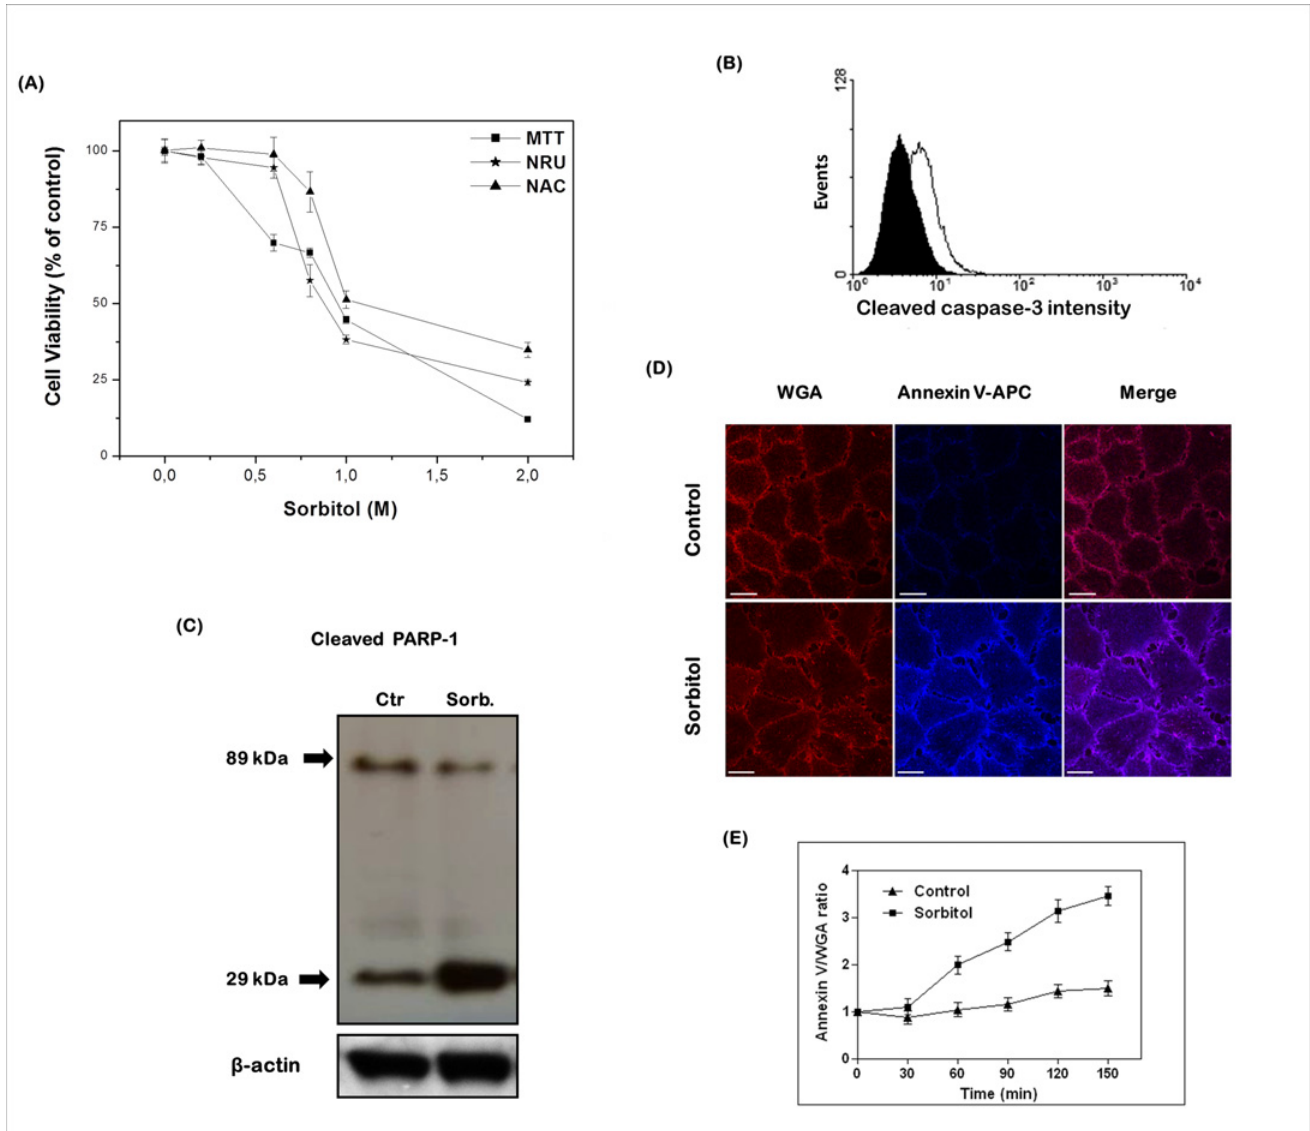
Fig 1. Sorbitol cytotoxicity in HaCaT cells involves induction of apoptosis. (A) Confluent layers of HaCaT cells were challenged with different concentrations of sorbitol (0.2 – 2 M in serum-free culture medium) for 2 h, and cellular viability was assessed by three different endpoints assays [MTT reduction (MTT), neutral red uptake (NRU) and nucleic acid content (NAC)]. The results were expressed as percentage of control cell viability (100%) and represented as mean ± SD of three independent experiments run in quadruplicate. HaCaT cells exposed to 1 M sorbitol for 2 h exhibited typical signs of apoptosis. (B) Increased fluorescence intensity of the large fragment (17/19 kDa) of activated caspase-3 detected by flow cytometry in stressed (open histogram) relative to control (black histogram) cells. One representative histogram of three independent experiments for each sample is presented. (C) Increased levels of the small fragment of cleaved PARP-1 by immunoblotting. Equal amounts of total protein (50 μ g) from cell lysates were loaded per lane and blotted with specific antibodies. One representative immunoblot of three independent experiments is presented. (D) Increased phosphatidylserine exposition on the extracellular face of the membranes of stressed compared to control cells, as shown by confocal microscopy analysis of membrane labeled with WGA594 (red) and phosphatidylserine exposure labeled with annexin V-APC (blue). Images are representative of three independent experiments at the end of treatment (2 h). Bars = 20 μ m. (E) Time-dependent increase in the relative fluorescence intensity of annexin V/WGA was quantified from temporal images captured with intervals of 10 min in experiment depicted in (D) , using the Examiner 4.2 software. The results were expressed as mean ± standard deviation of the relative fluorescence intensities of each cell per field of view. At least three different fields were analyzed in three independent